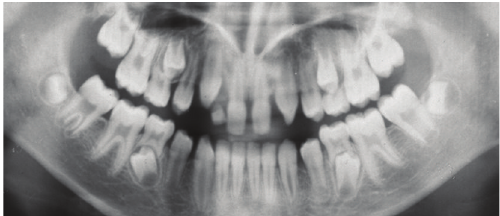
Figure 3: OTP (11 years 3 months) showing agenesis of the upper lateral incisors, taurodontism of the molars, and microdontia with crown hypoplasia of the upper central incisors and congenital missing 18 and 28 in patient 2.